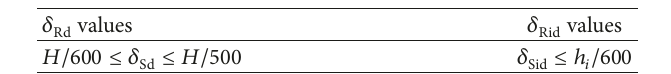
𝛿 Rid values ≤ ℎ Sid 𝑖